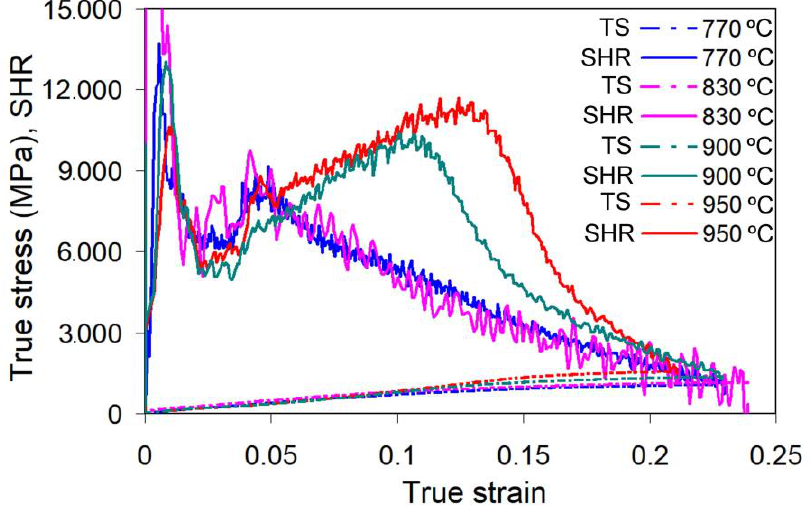
Figure 11. The curves of true strain (TS) and SHR for the specimens depending on the austenitiz- ing